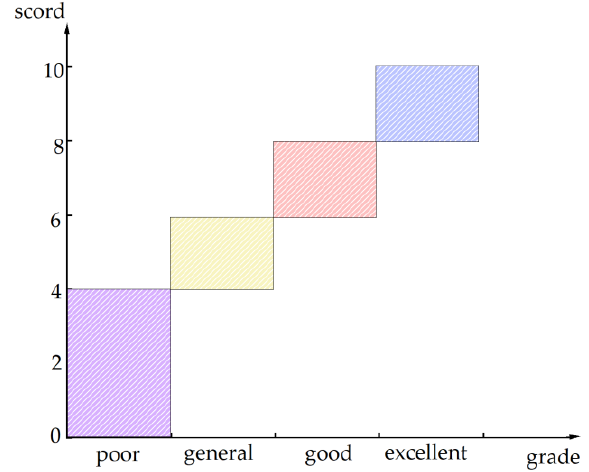
Figure 5. Evaluation quantification chart.